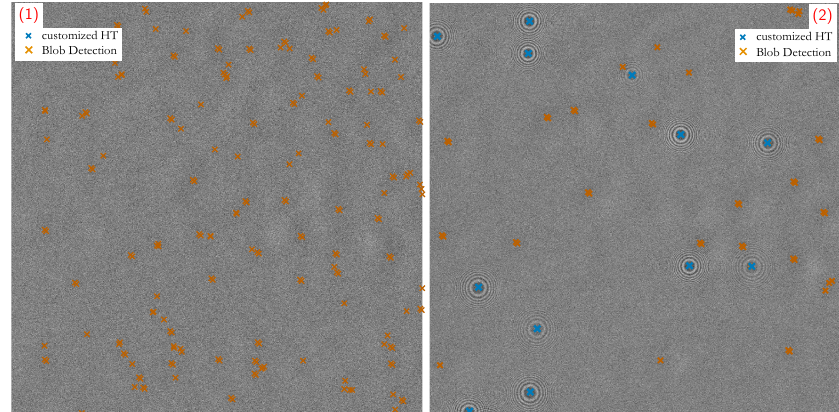
Figure 8. Zoomed segments of measurement samples from Figure 7b that suffer strong background fluctuations: ( 1 ) zero-particle frame; ( 2 ) particle number concentration of C N = 194 #/cm 3 ; while the customized HT outputs correct hits (only True Positives), the blob detection in both scenarios fails (also False Positives) because of a misinterpreted intensity threshold in the